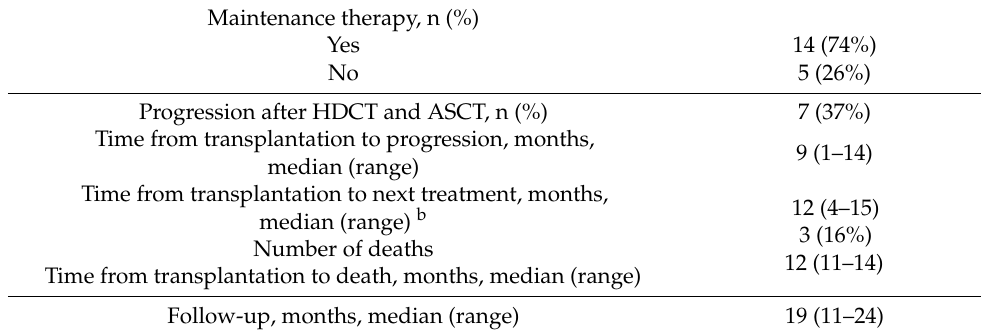
9 (1–14) 12 (4–15) 3 (16%) 12 (11–14)